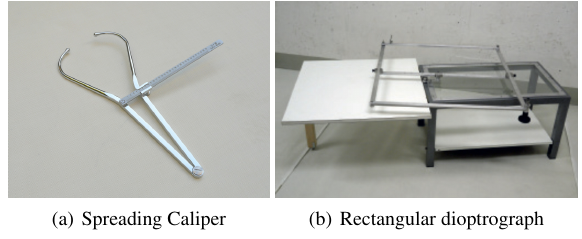
Figure 1. Anthropological mechanical